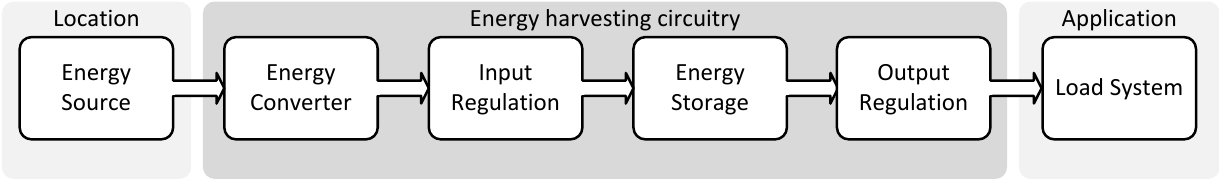
Figure 1. Generalized architecture of an energy harvesting